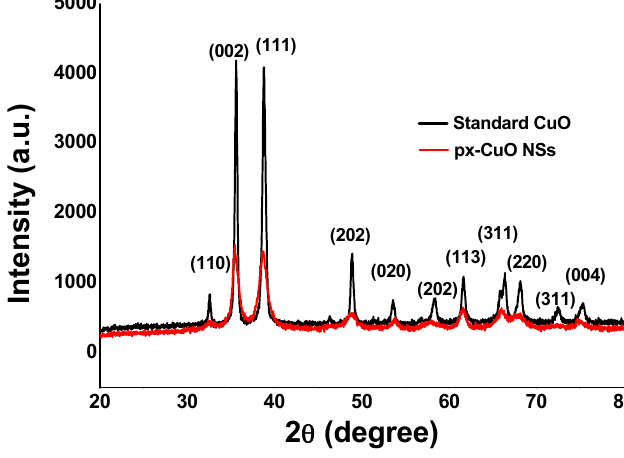
Figure 3. XRD crystalline patterns of Px-CuO NSs (red) and standard CuO (black).